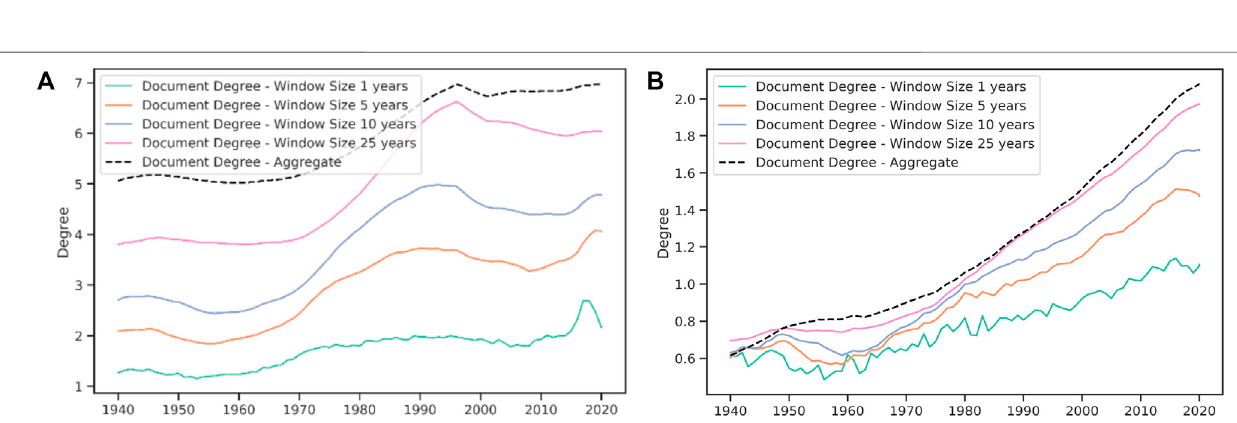
Frontiers in Physics |